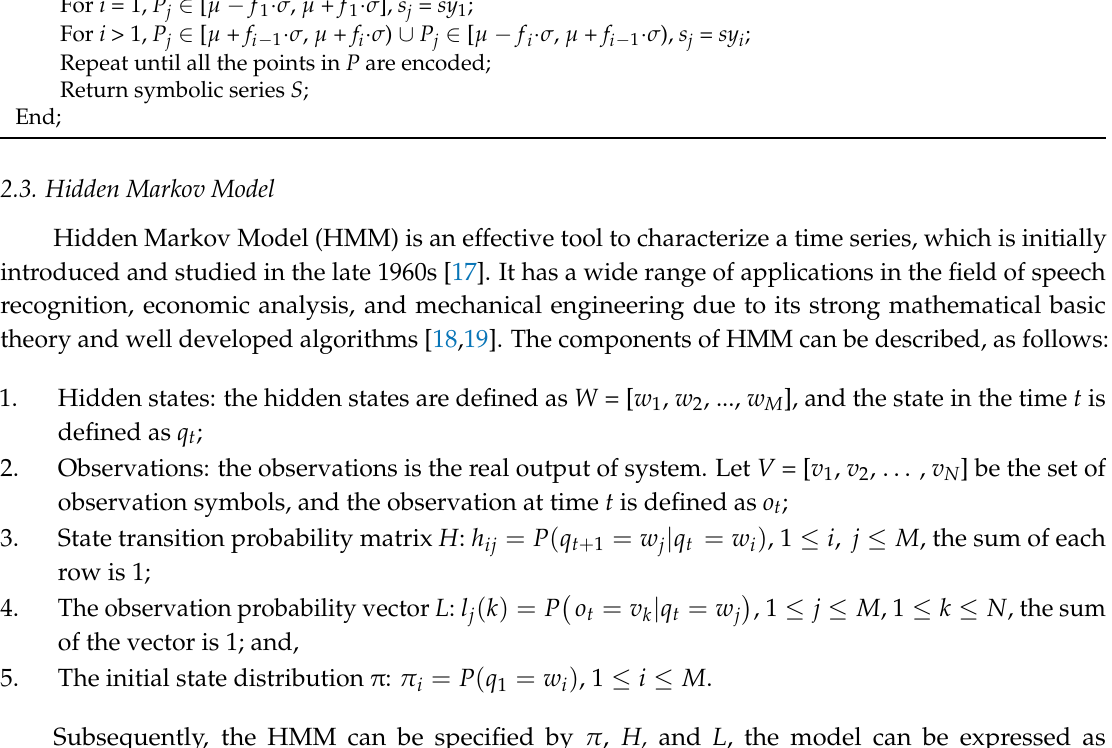
Algorithm 2: Symbolic